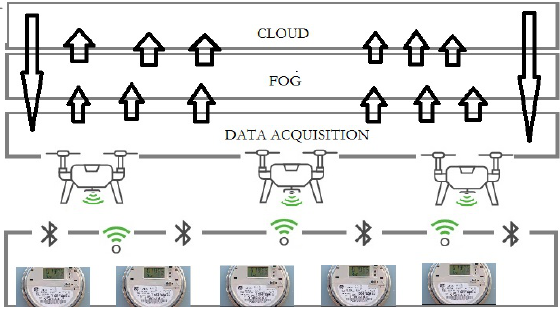
Fig. 5. Multi-layer IoT-Fog- Cloud Environment for smart energy meter in smart